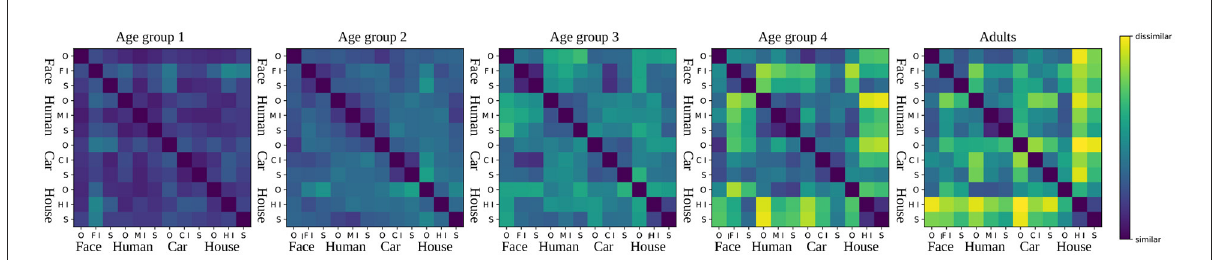
FIGURE8 Relative similarity between children’s drawings on one stimulus compared to another stimulus for all combinations of stimuli, separated for four different age groups of children as well as for adults. Blue indicates high similarity, and yellow indicates higher dissimilarity. Stimuli are labeled as O for outline, I for inner features, and S for scrambled features. Reproduced with permission from Philippsen et al. (2020).